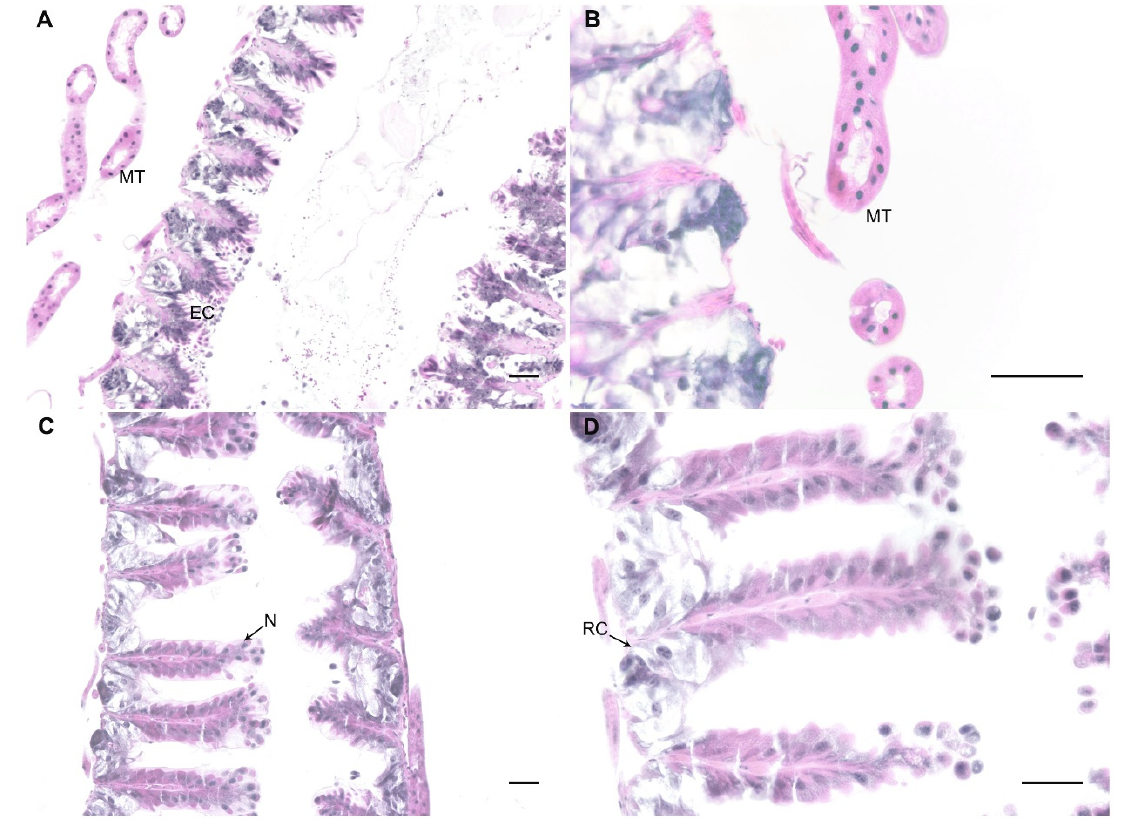
Figure 3. Examples of midgut sections under the light microscope of a portion of the ventriculus of control ( A ) and exposed bumblebees at days 9 ( B ) and 16 ( C , D ) post-exposure. No evidence of parasitic form was observed in the epithelium (EC), nor in the Malpighian tubules (MT). N: nuclei, RC: regenerative cells. Haematoxylin and eosin staining. Bar scale = 25 μ m.